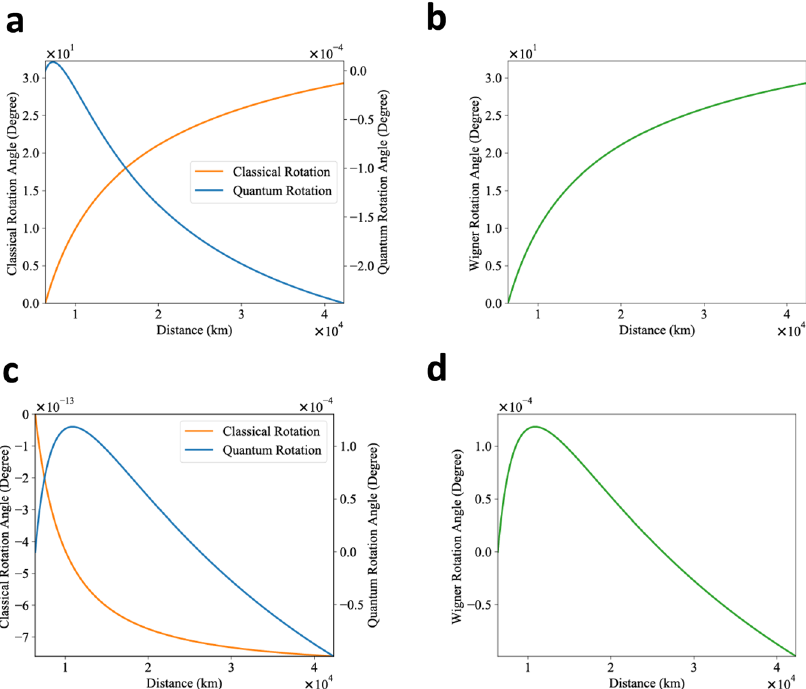
Fig. 4 WRA along distances from Earth. It is shown that the classical geodetic part in the solid orange line, the residual quantum-phase part in the solid blue line, and total WRA in green line for the circular orbit ( a , b ) and the spiraling orbit ( c , d